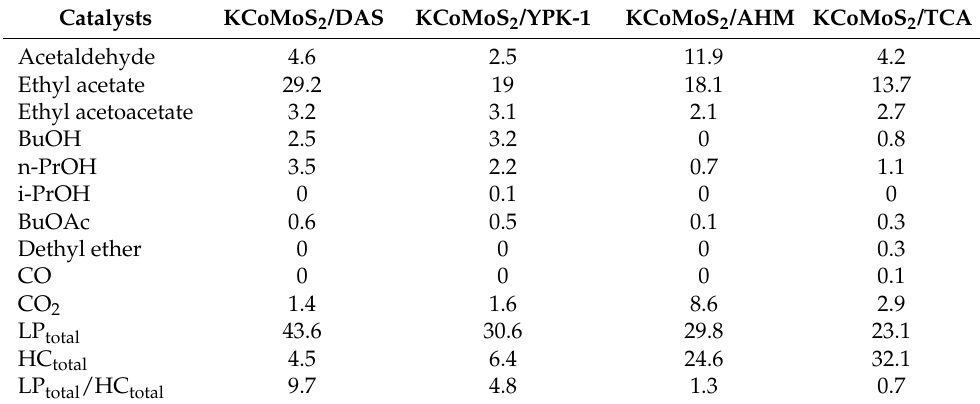
Table 4. Product yields from ethanol over KCoMoS 2 -supported